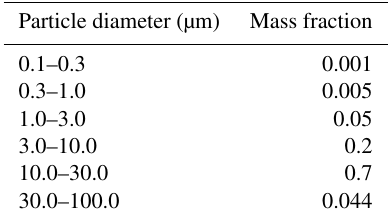
Table 2. The default input source PSD used in NAME by the Lon- don